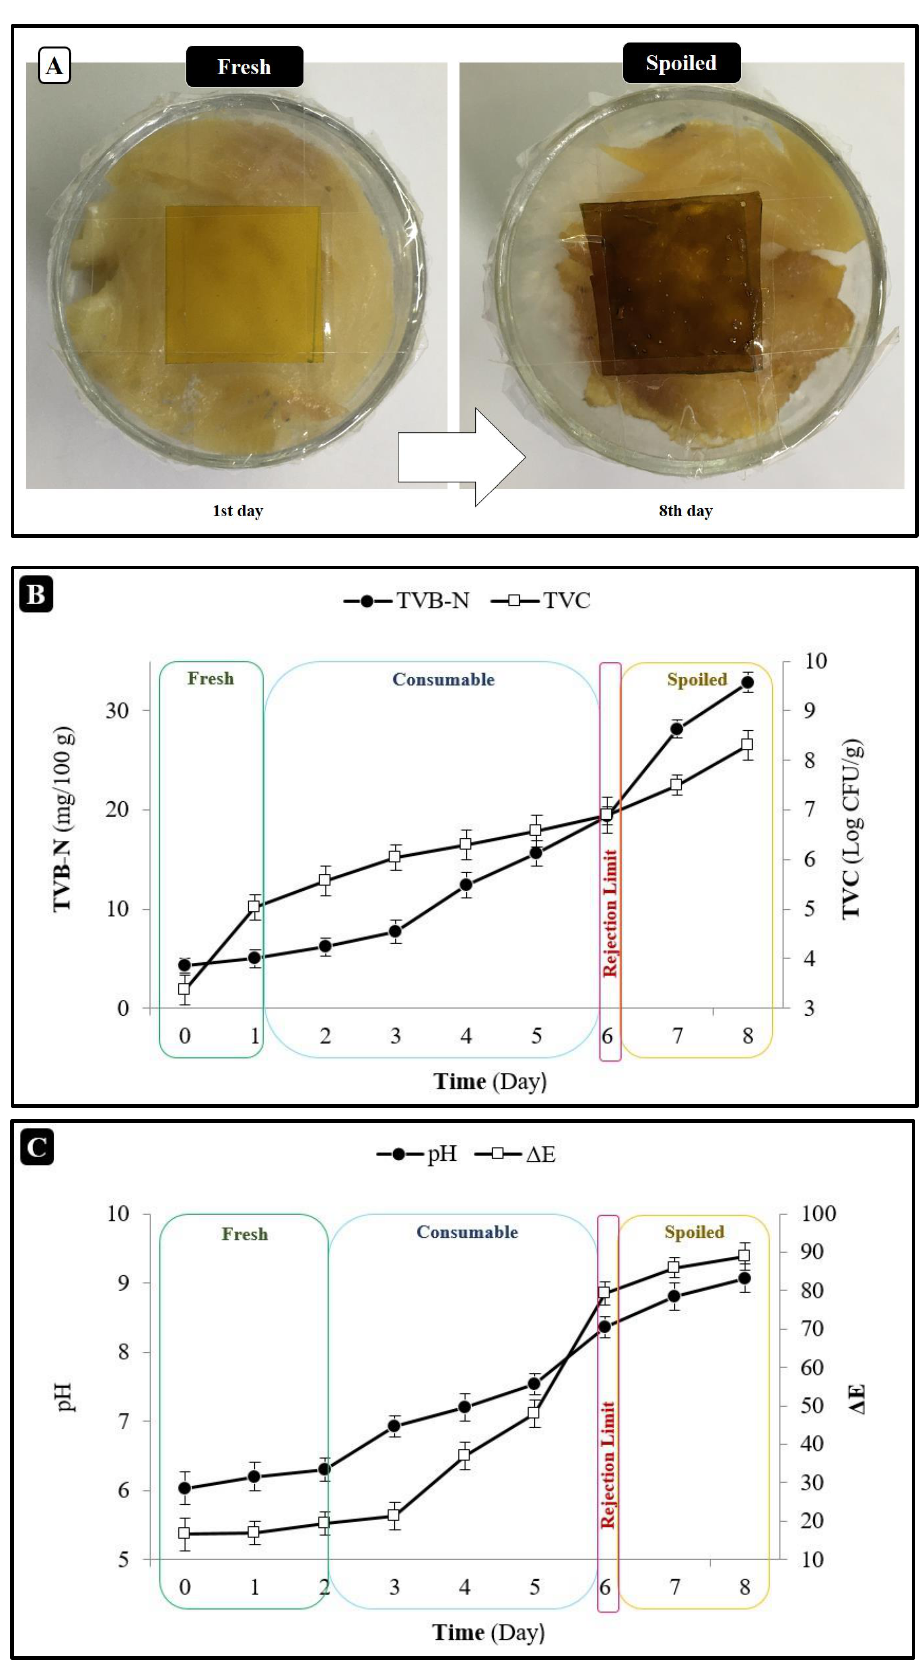
Figure 7. Changes in ( A ) freshness of rainbow trout fillet, ( B ) TVB-N and TVC, and ( C ) pH and ΔE values during storage at 4 °C using salep mucilage edible indicator films.